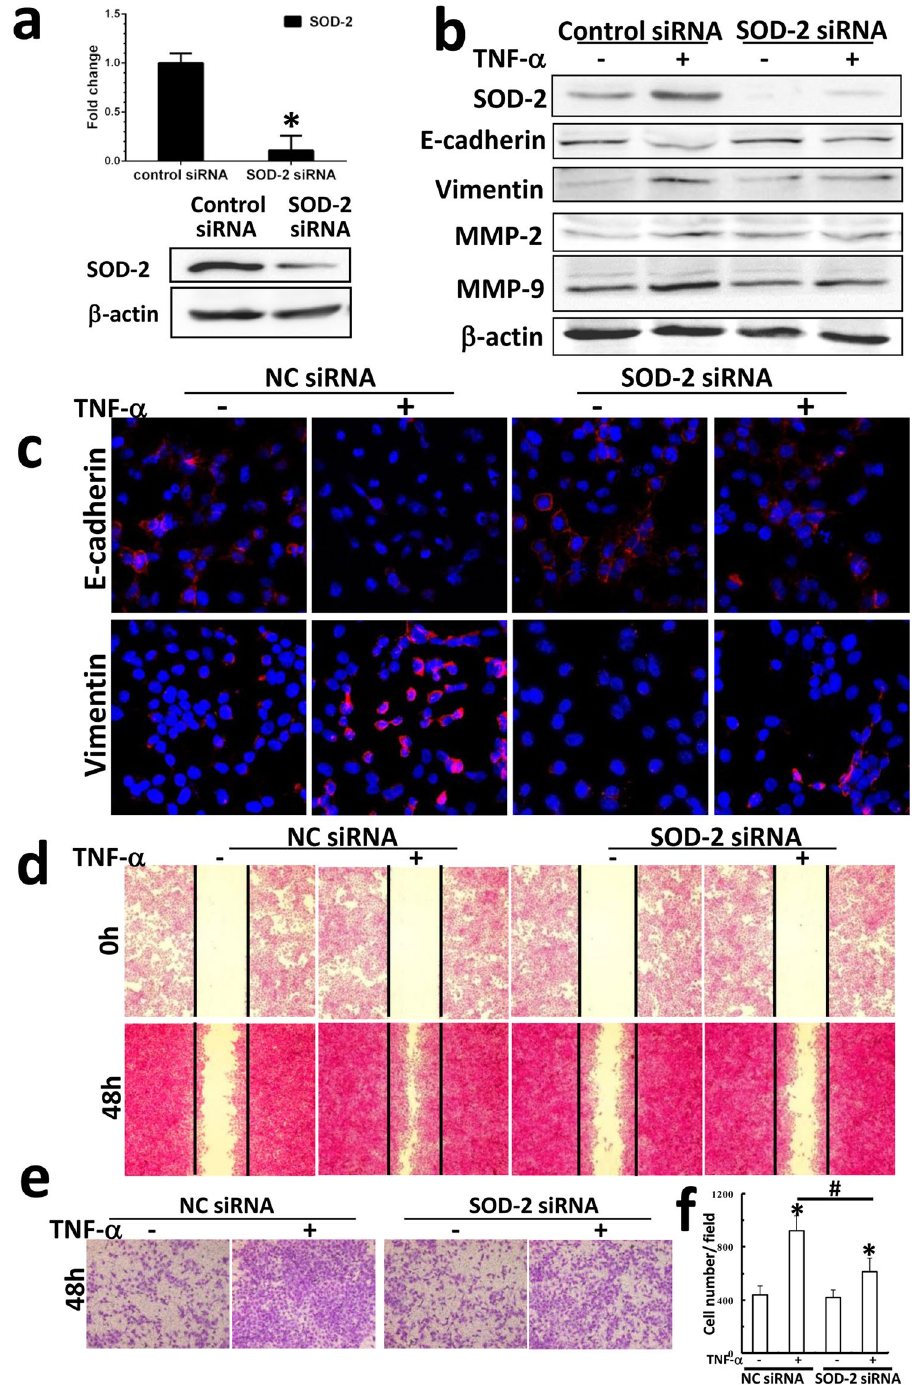
Figure 6. SOD-2 contributed to TNF- α -mediated EMT and migration in A549 cells. ( a ) The expression of SOD-2 at mRNA and protein level was significant inhibited after transfection with SOD-2 siRNA in A549 cells. ( b ) After 72 h of TNF- α treatment, the expression of SOD-2, E-cadherin, vimentin, MMP2 and MMP9 in A549 cell transfected with SOD-2 siRNA was detected by Western blot. ( c ) Representative immunofluorescent micrographs show the expression of E-cadherin and vimentin in SOD-2-knockdown cells. After TNF- α treatment for 48 hours, the migration ability of A549 cell transfected with SOD-2 siRNA was measured by wound healing migration assay ( d ) and transwell migration assay ( e ). ( f ) Cell number was determined by counting the positive cells number in higher field and data was shown as mean ± SD (three experiments, * p < 0.05, compared to control; # p < 0.05, control cells treated with TNF- α compared to SOD-2-knockdown cells treated with TNF- α